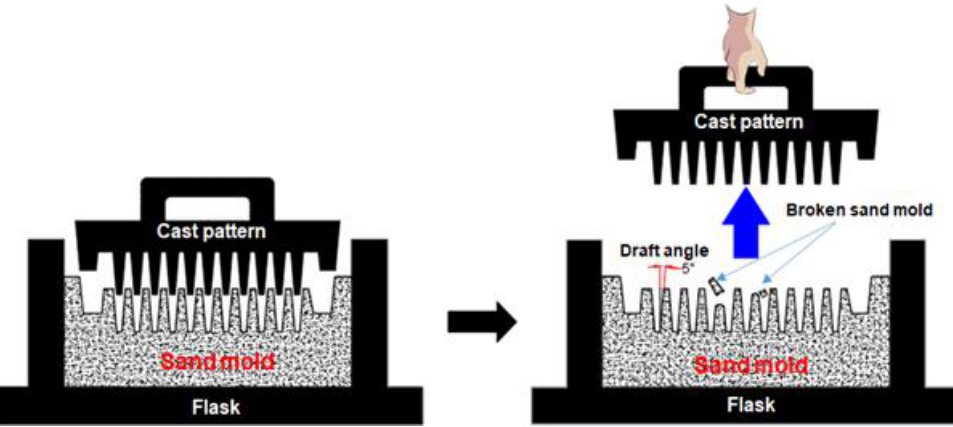
Figure 1. Draft angle for manufacturing a bar plate through the sand casting and breakage of sand mold during removal of the cast pattern.